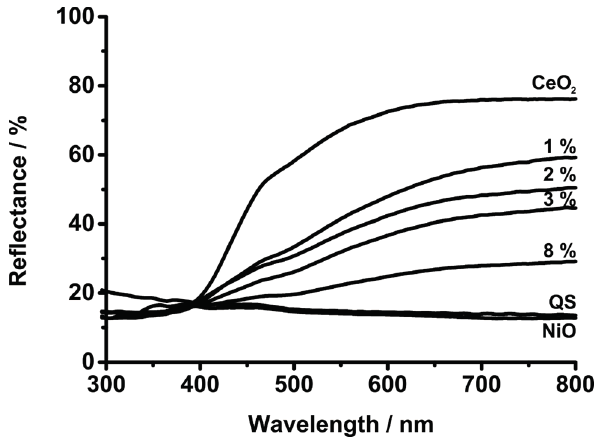
Figure 5. Diffuse-reflectance spectra of nickel-doped CeO 2 samples, with reflectance intensity decreasing markedly with increased nickel doping. “QS” is the reflectance spectrum of blank quartz